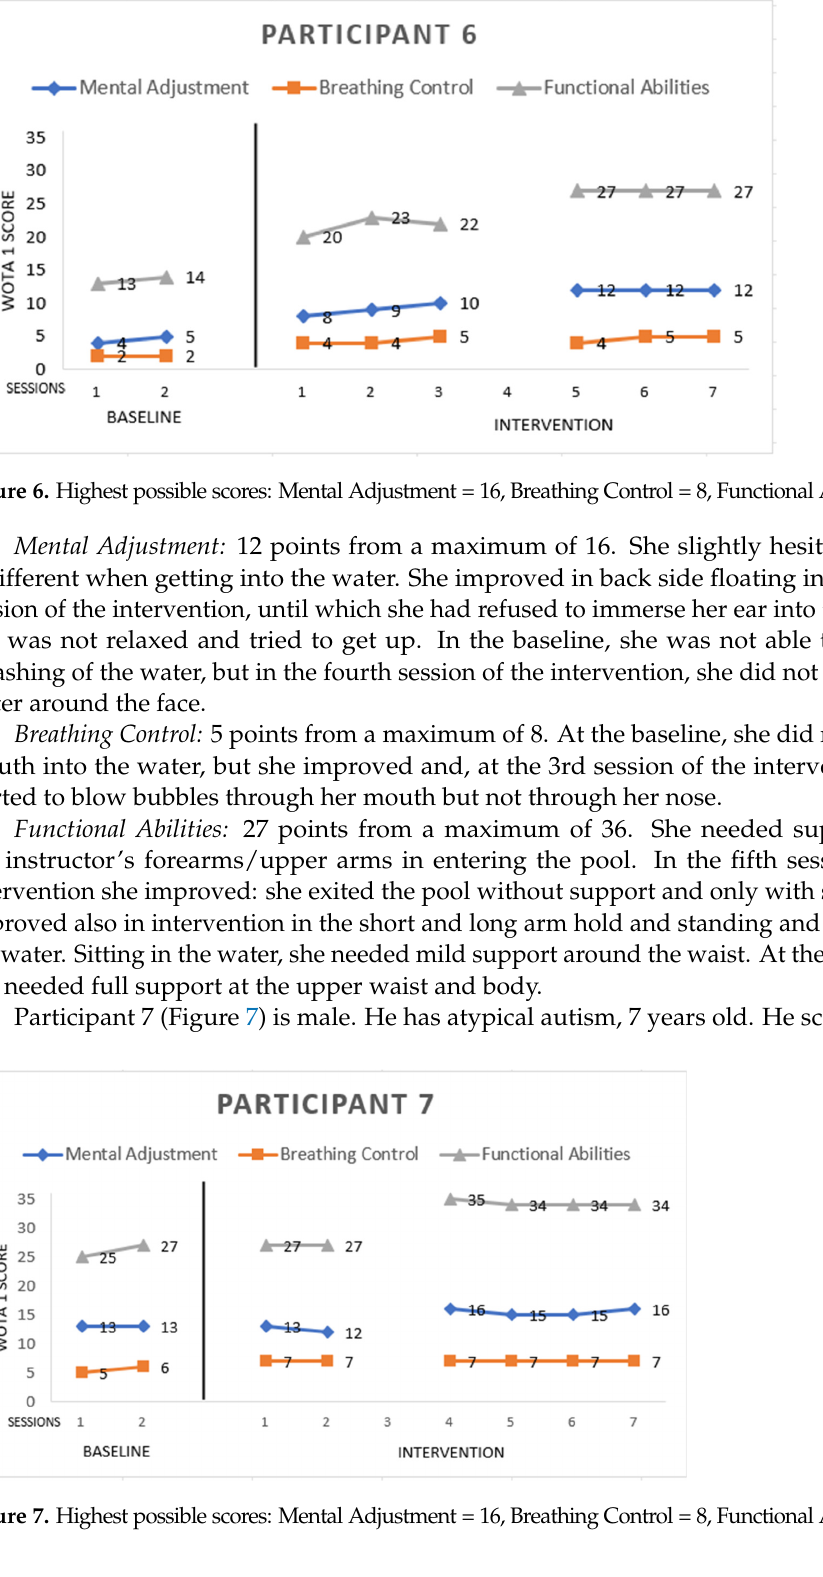
Figure 7. Highest possible scores: Mental Adjustment = 16, Breathing Control = 8, Functional Abilities = 36.